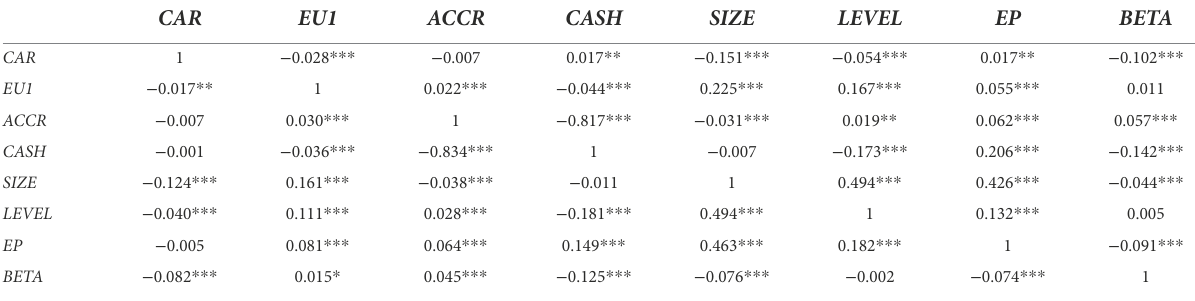
TABLE 3 Correlation coefficient between